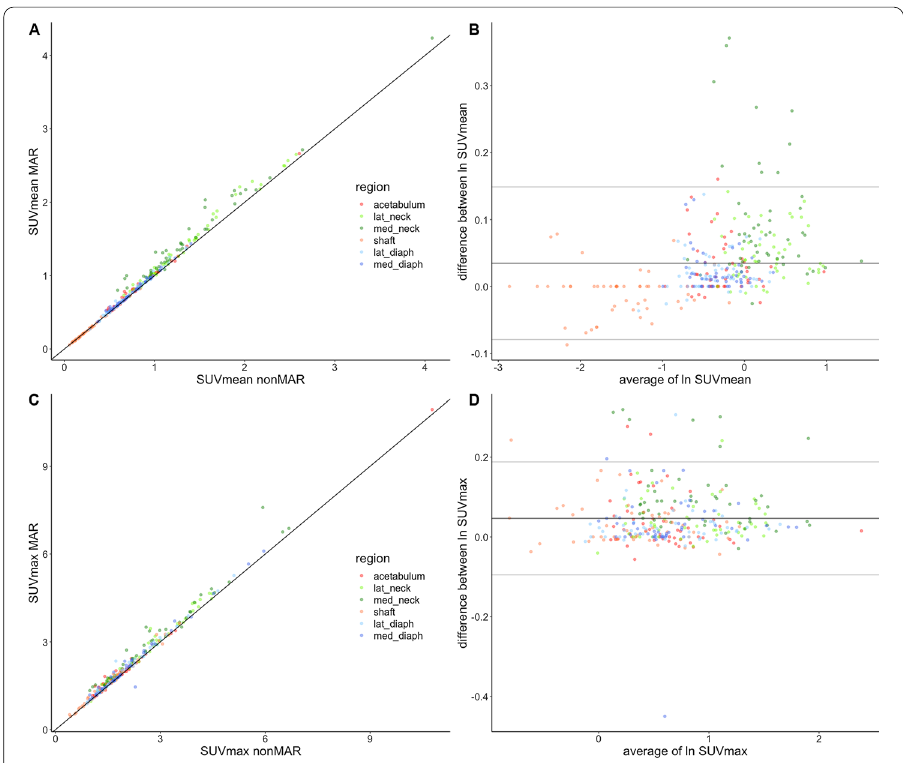
Fig. 8 Correlation and Bland–Altman plots of SUV with and without MAR in regions around the prostheses. In the correlation plots (panels A , SUV mean and C , SUV max ), almost all points lie above the line of identity. The Bland–Altman plots (panels B , SUV mean and D , SUV max ) use log-transformed data, and horizontal lines indicate the mean value and 95% confidence boundaries of the differences. Data from different regions are colour coded. lat_neck lateral neck; med_neck medial neck; lat_diaphysis lateral diaphysis; med_diaphysis medial